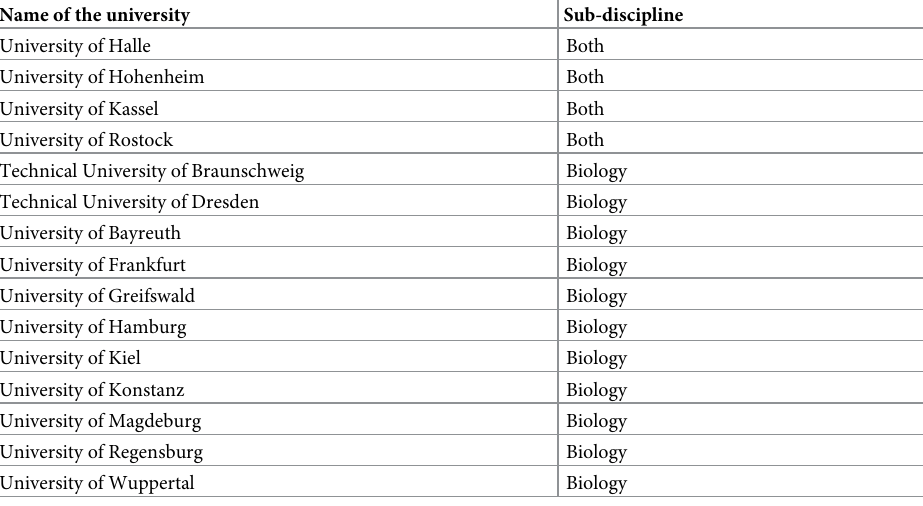
Table 8. Latent class two members. Source: own